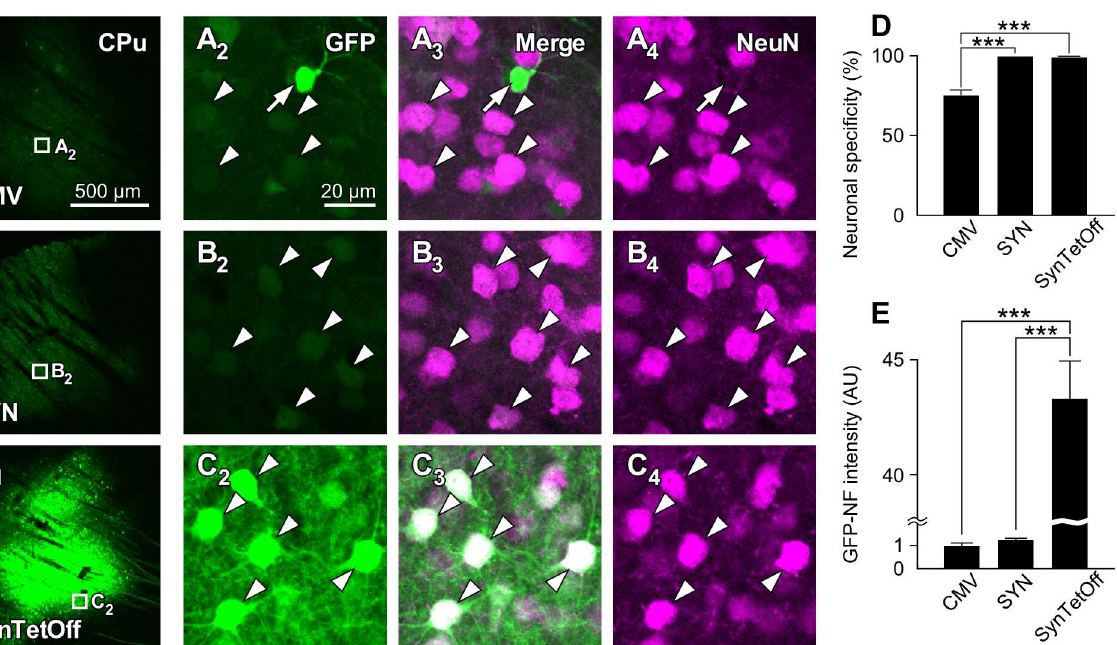
PLOS ONE | DOI:10.1371/journal.pone.0169611 January6,